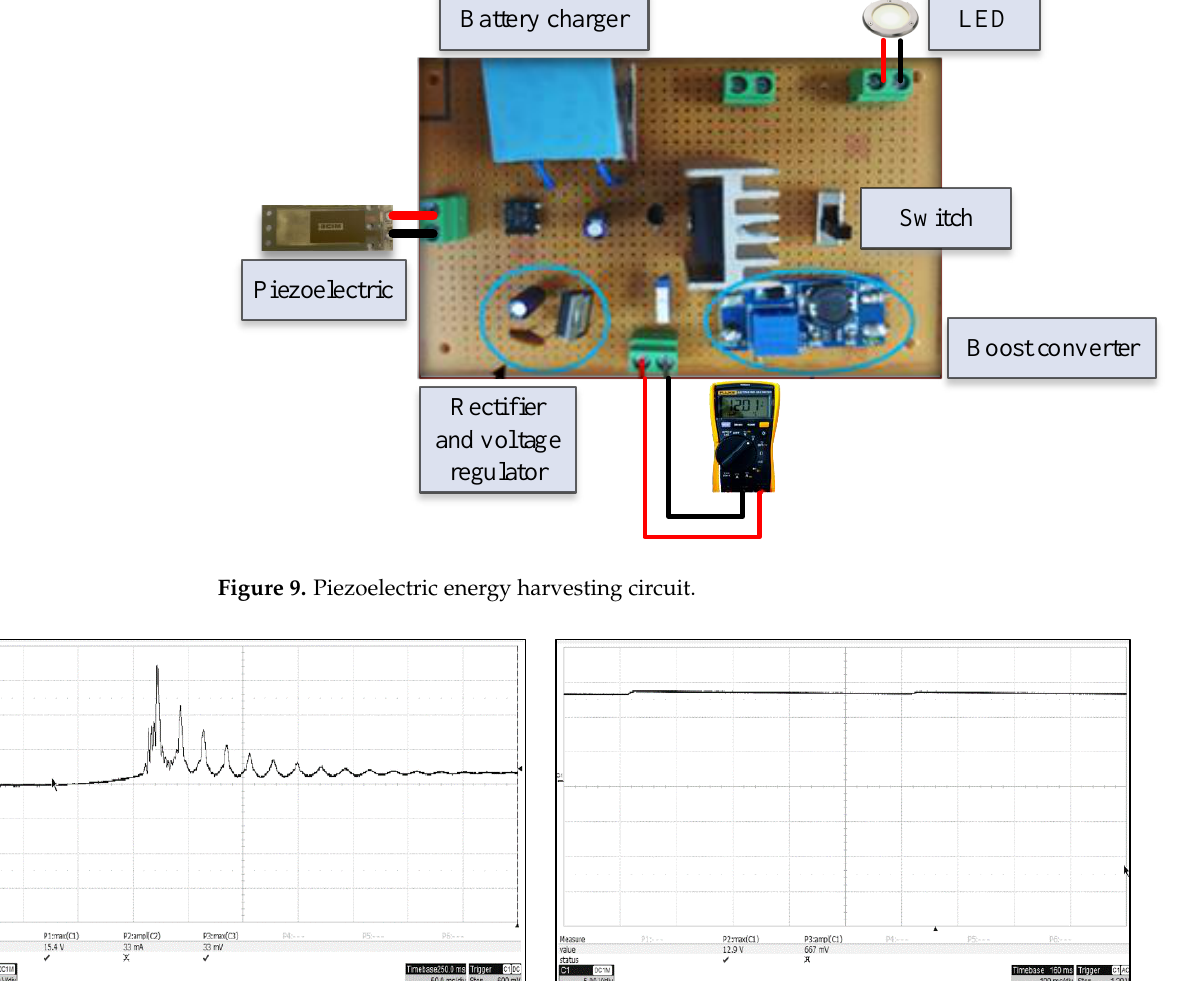
Table 4. Voltage measurements with and without the spring installed on the power-generating floor .